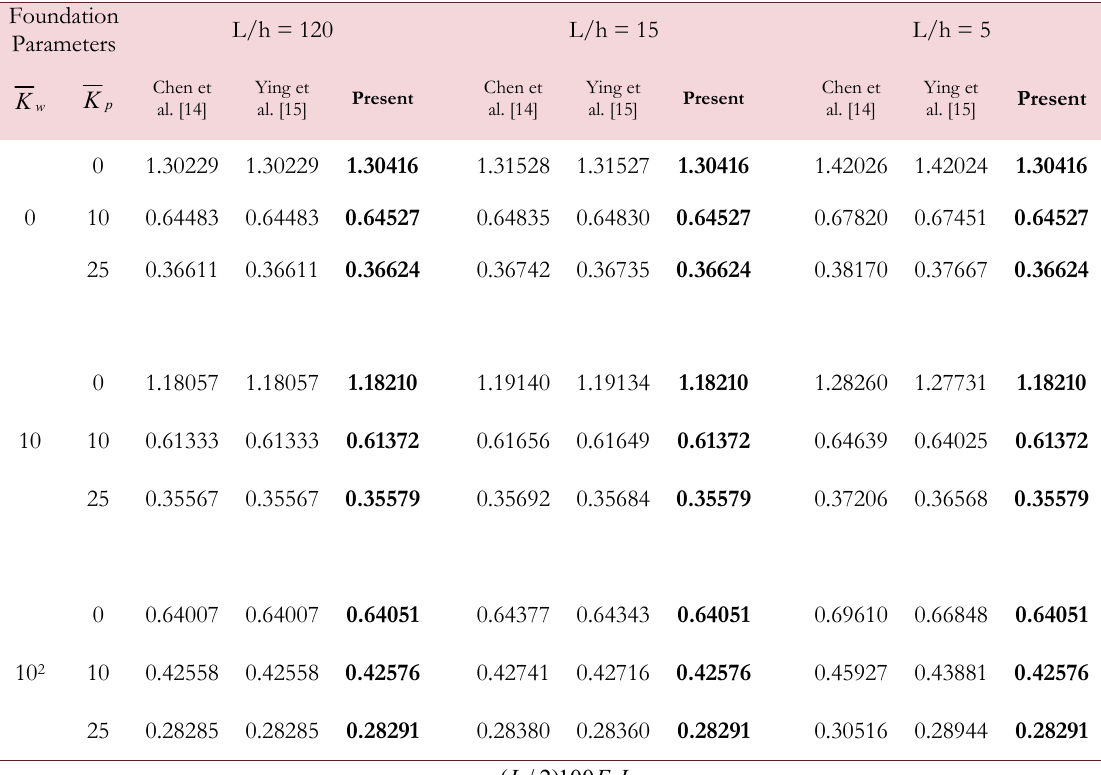
Table 1 Comparisons of the mid-span